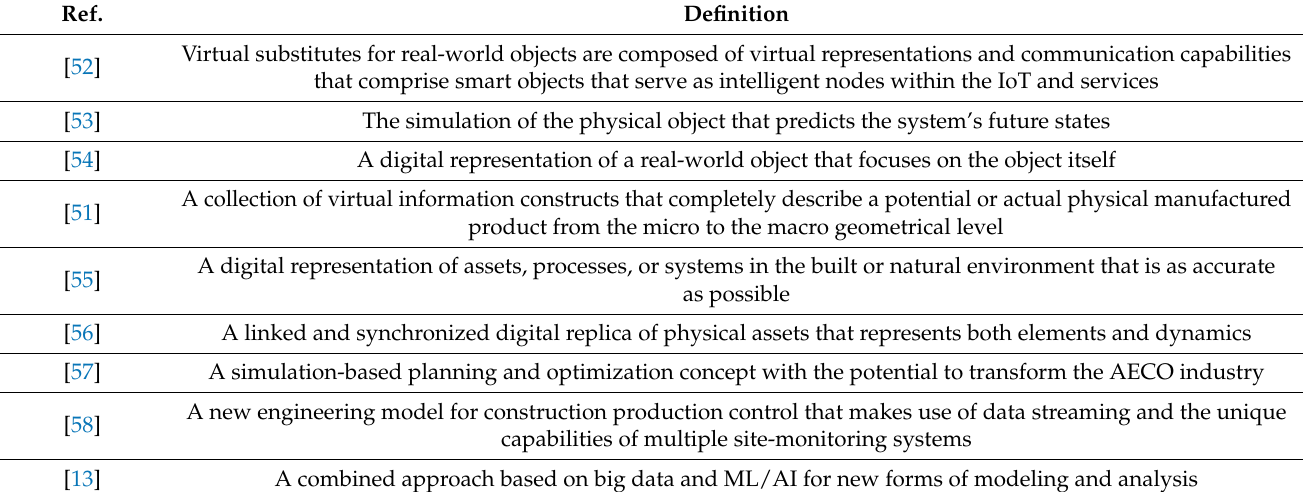
Table 1. Definitions of